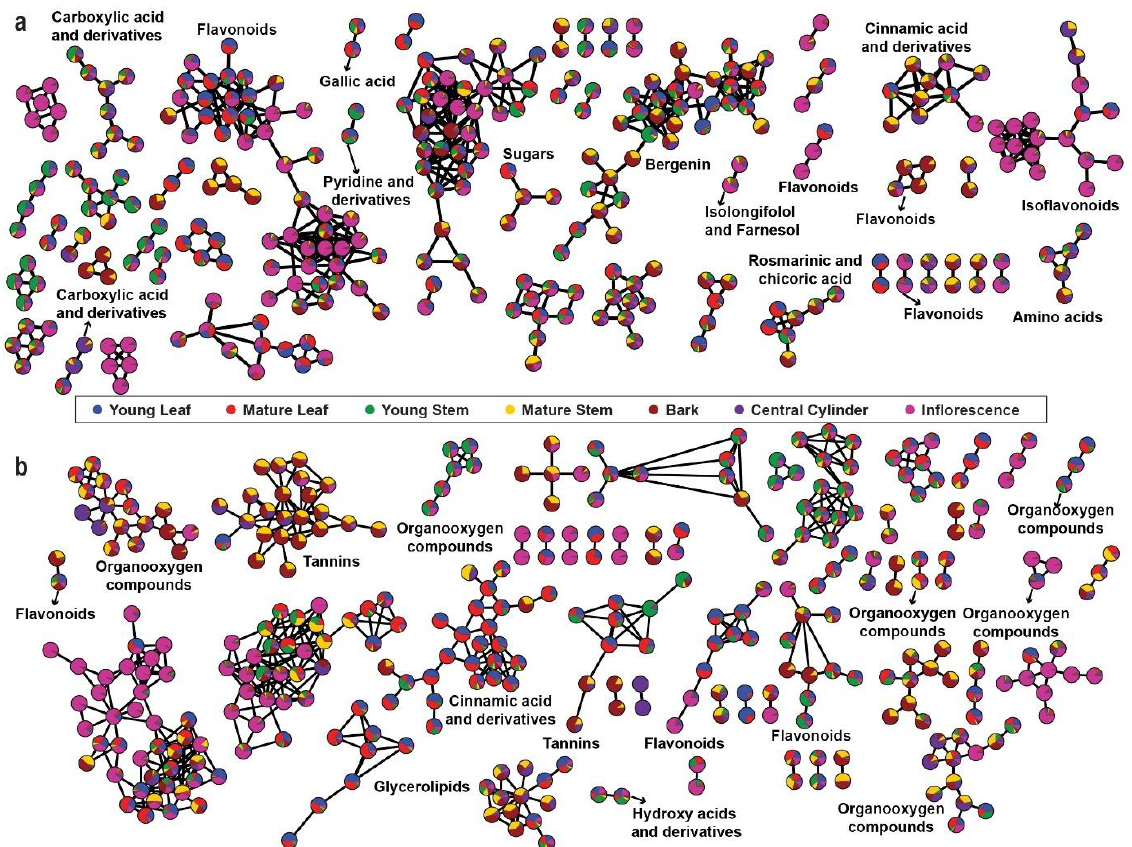
Figure 3. Feature-based Molecular Networking (FBMN) using the metabolome datasets acquired in the ( a ) positive mode and ( b ) negative mode. The pie charts on the nodes are drawn according to the accumulation pattern of the assigned metabolites across seven tissues of Mallotus japonicus .